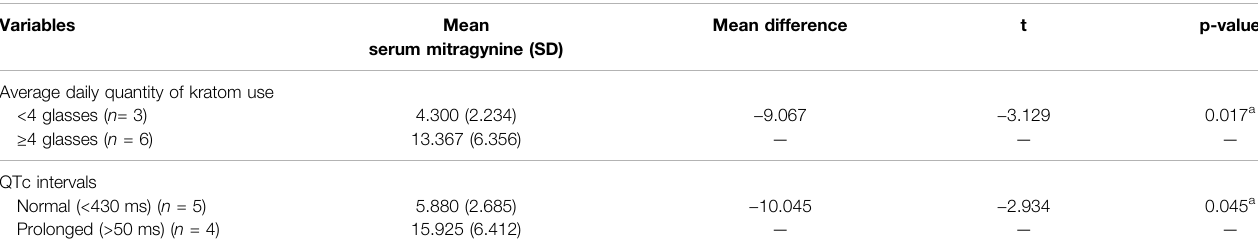
TABLE 3 | The association between average daily quantity of kratom use, QTc intervals, and serum level of mitragynine among the regular kratom users. Variables p-value